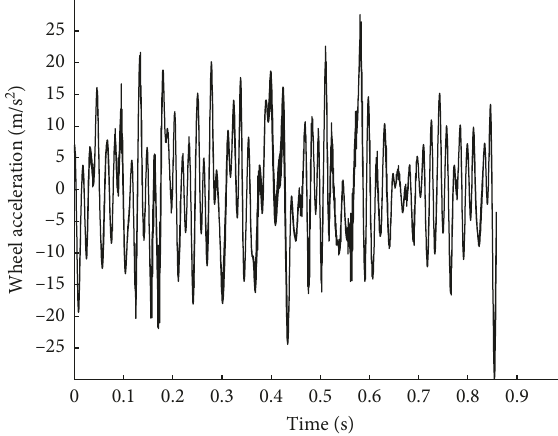
Figure 4: Simulated signal of wheel